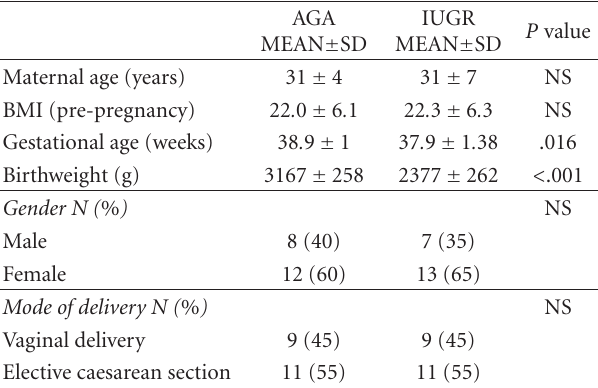
Table 1: Demographic data of participating infants (appropriate for gestational age-AGA and intrauterine growth restricted-IUGR) and of their